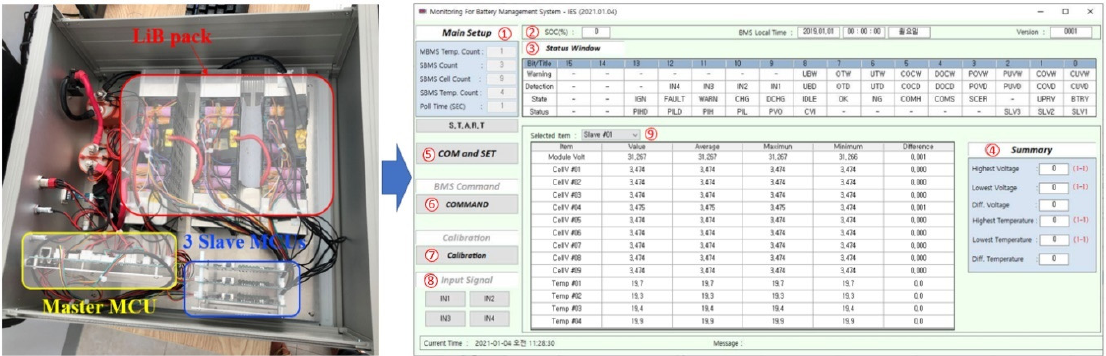
Figure 15. Monitoring system for the smart BMS.